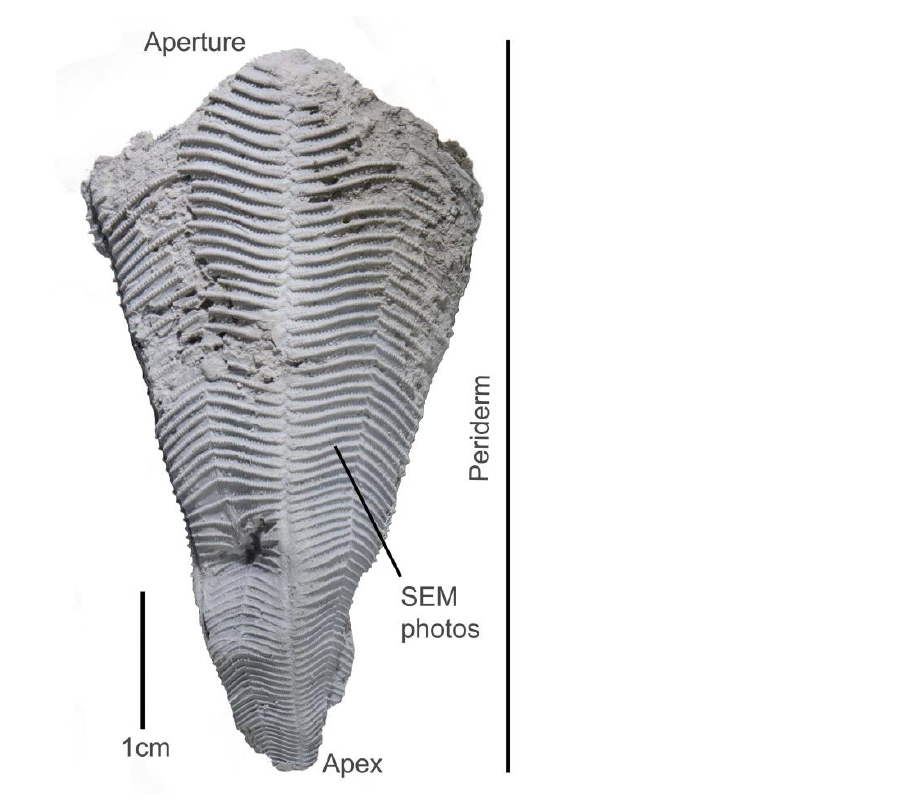
Figure 1. Periderm of a conulariid ( Holoconularia ) showing location of SEM images. The conulariid anatomy is based on Ford et al. [14].